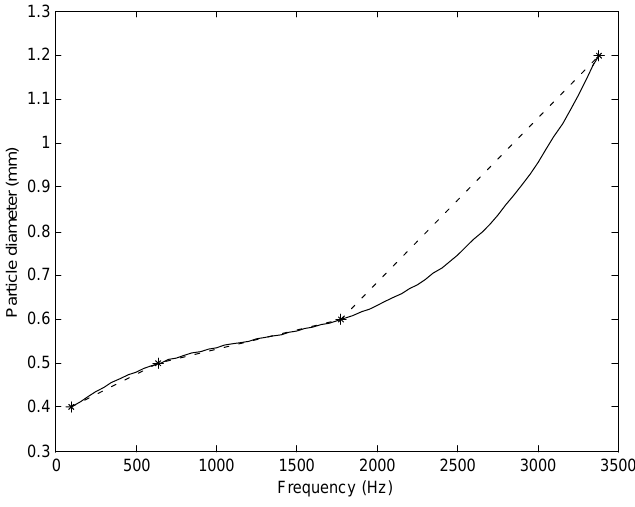
Fig. 15. The relationship between particle diameter and